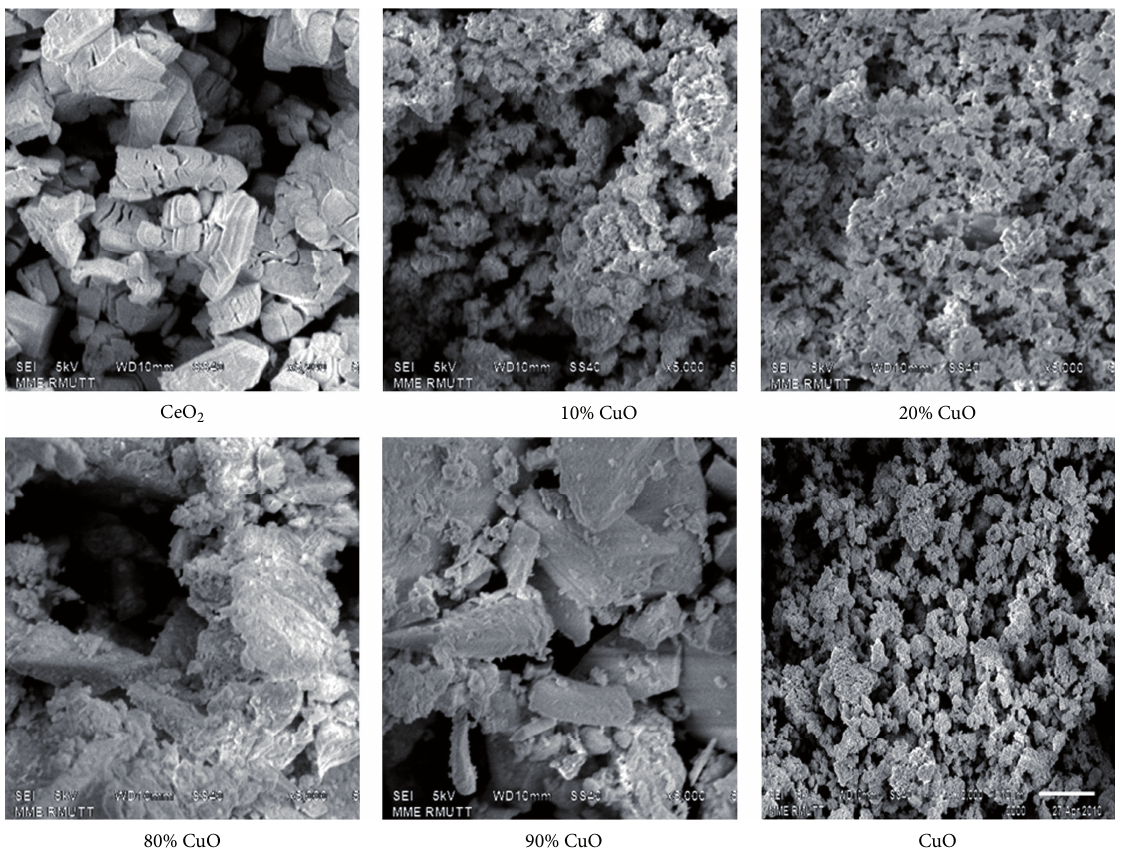
Figure 3: SEM micrographs of the catalysts with the percentage numbers below each picture indicated the level of CuO loading by wt.%.